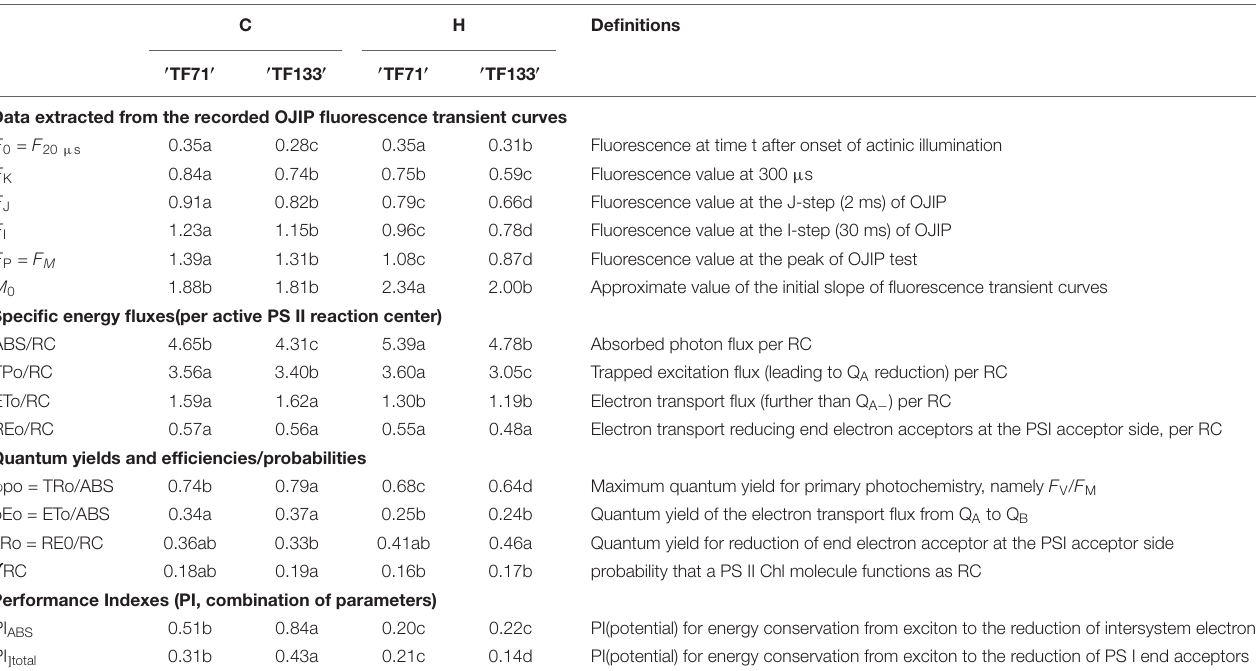
The calculation of each parameter follows the method of Yusuf et al. (2010). Subscript “0” indicates that the parameter refers to the onset of illumination. Values are given as the average of five replicates, and different letters indicated statistical difference significance at P < 0.05 among the different treatments groups by Duncan’s multiple range